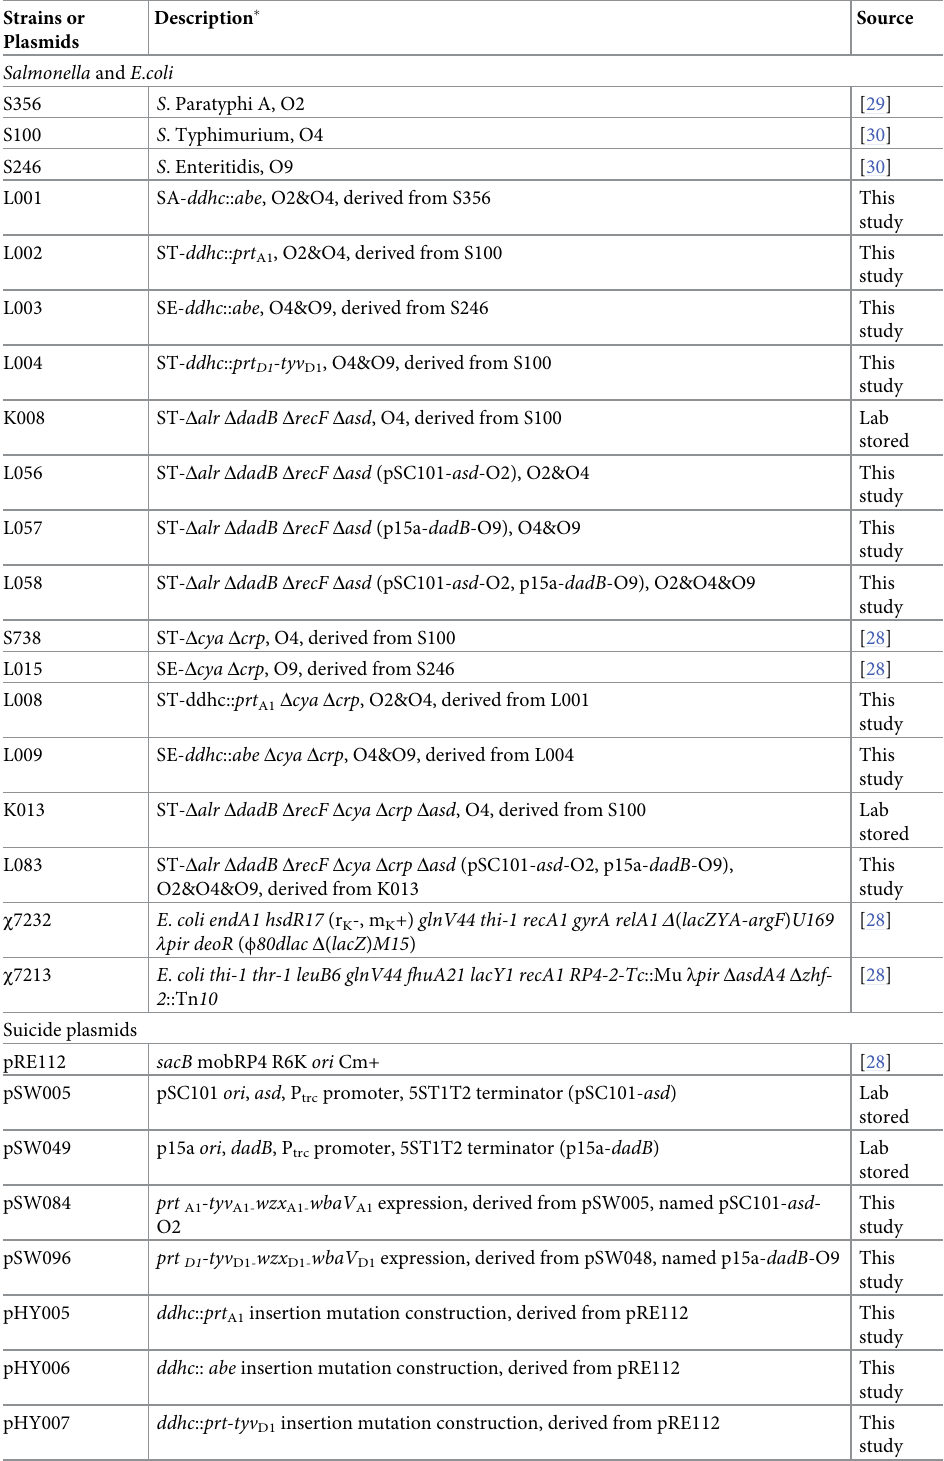
Table 1. Bacterial strains and plasmids used in this